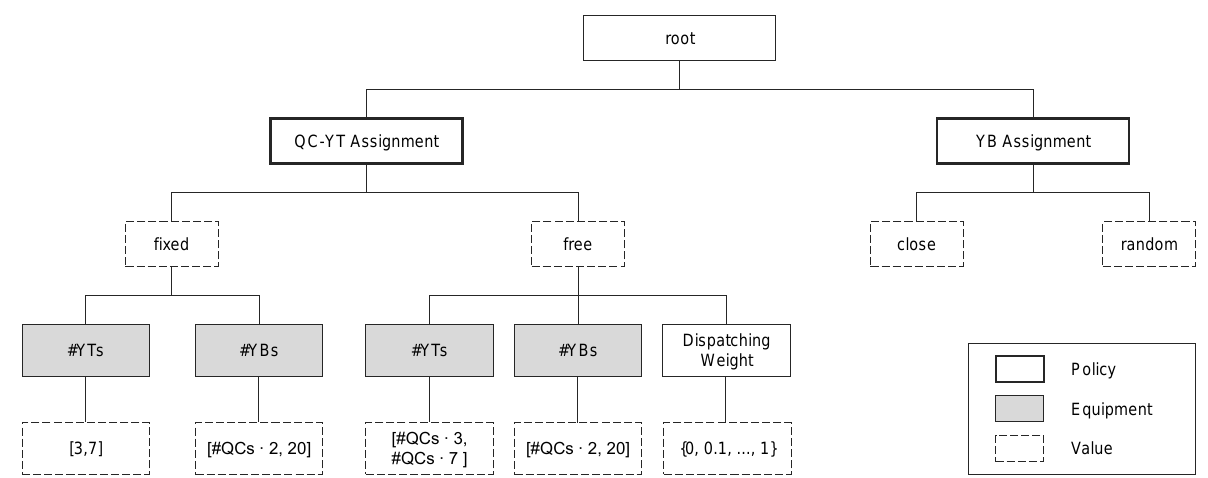
Figure 5. The parameter configuration space in tree